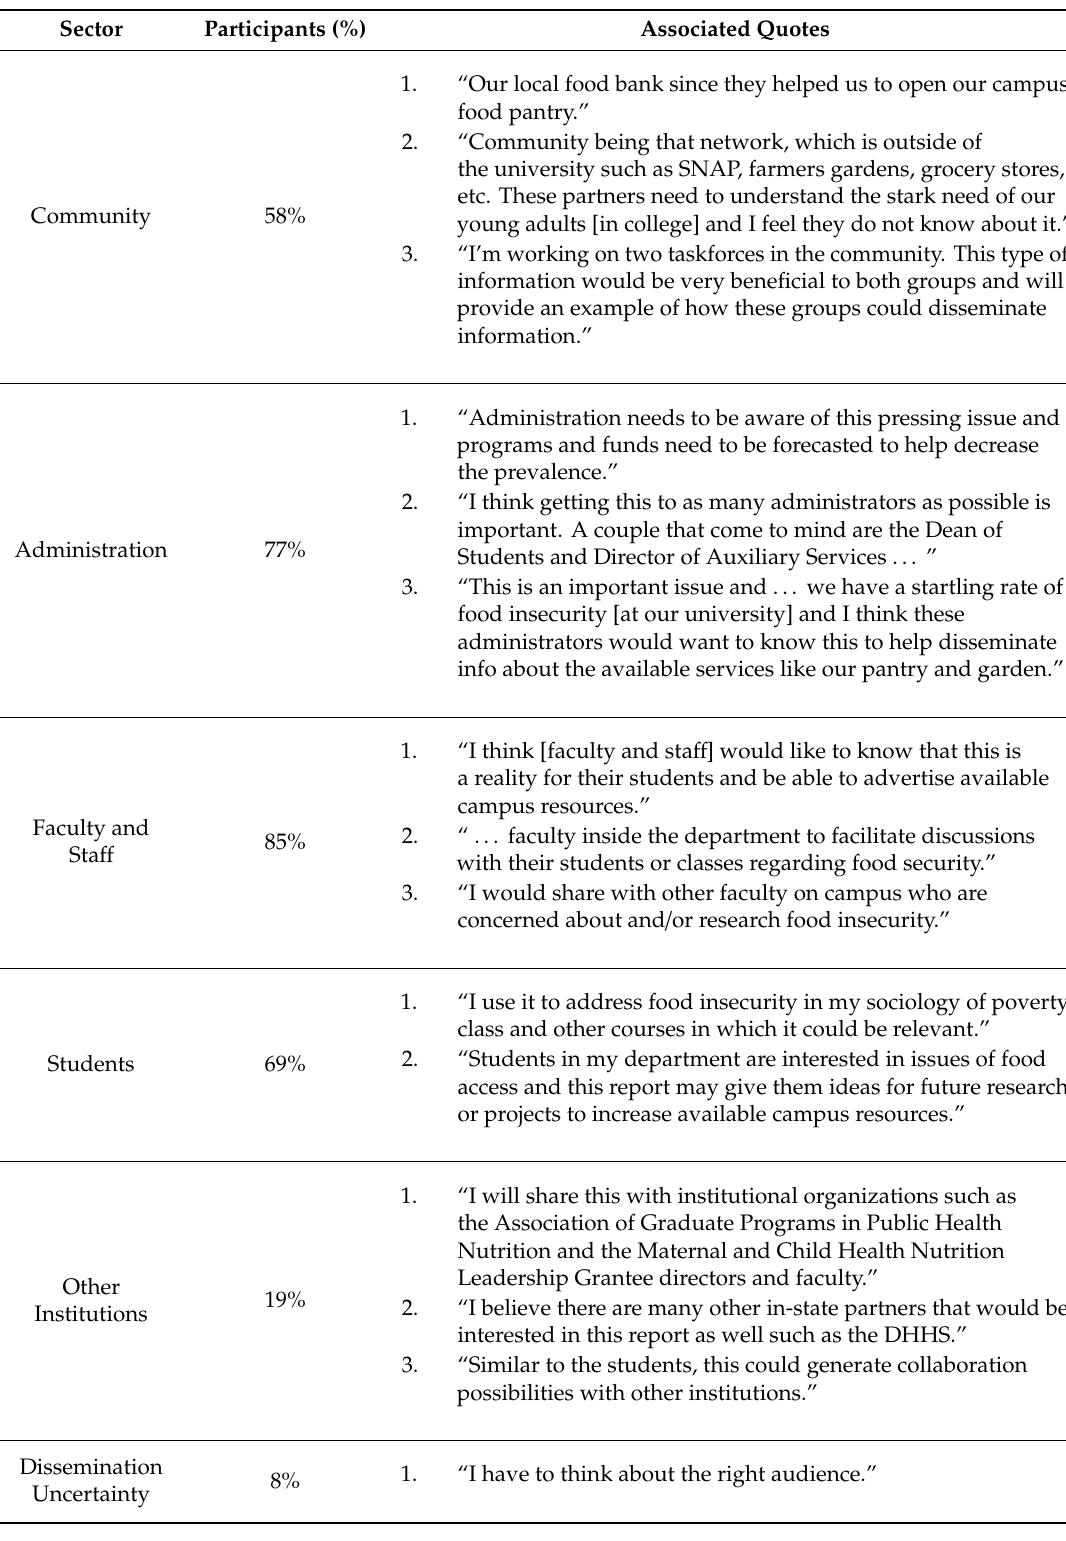
Table 3. Suggested dissemination plans within